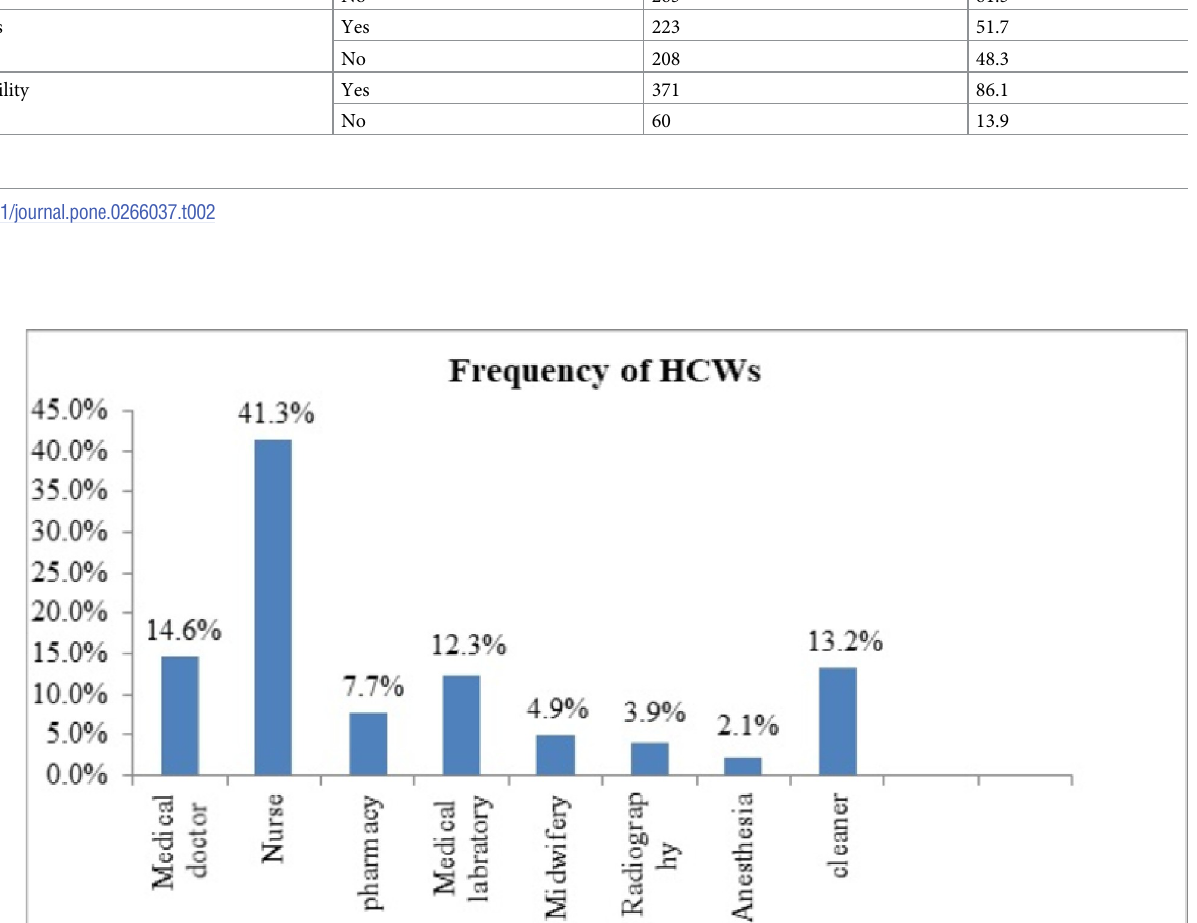
Fig 1. Profession or job distribution of health care workers in metropolitan cities private hospitals of Amhara region